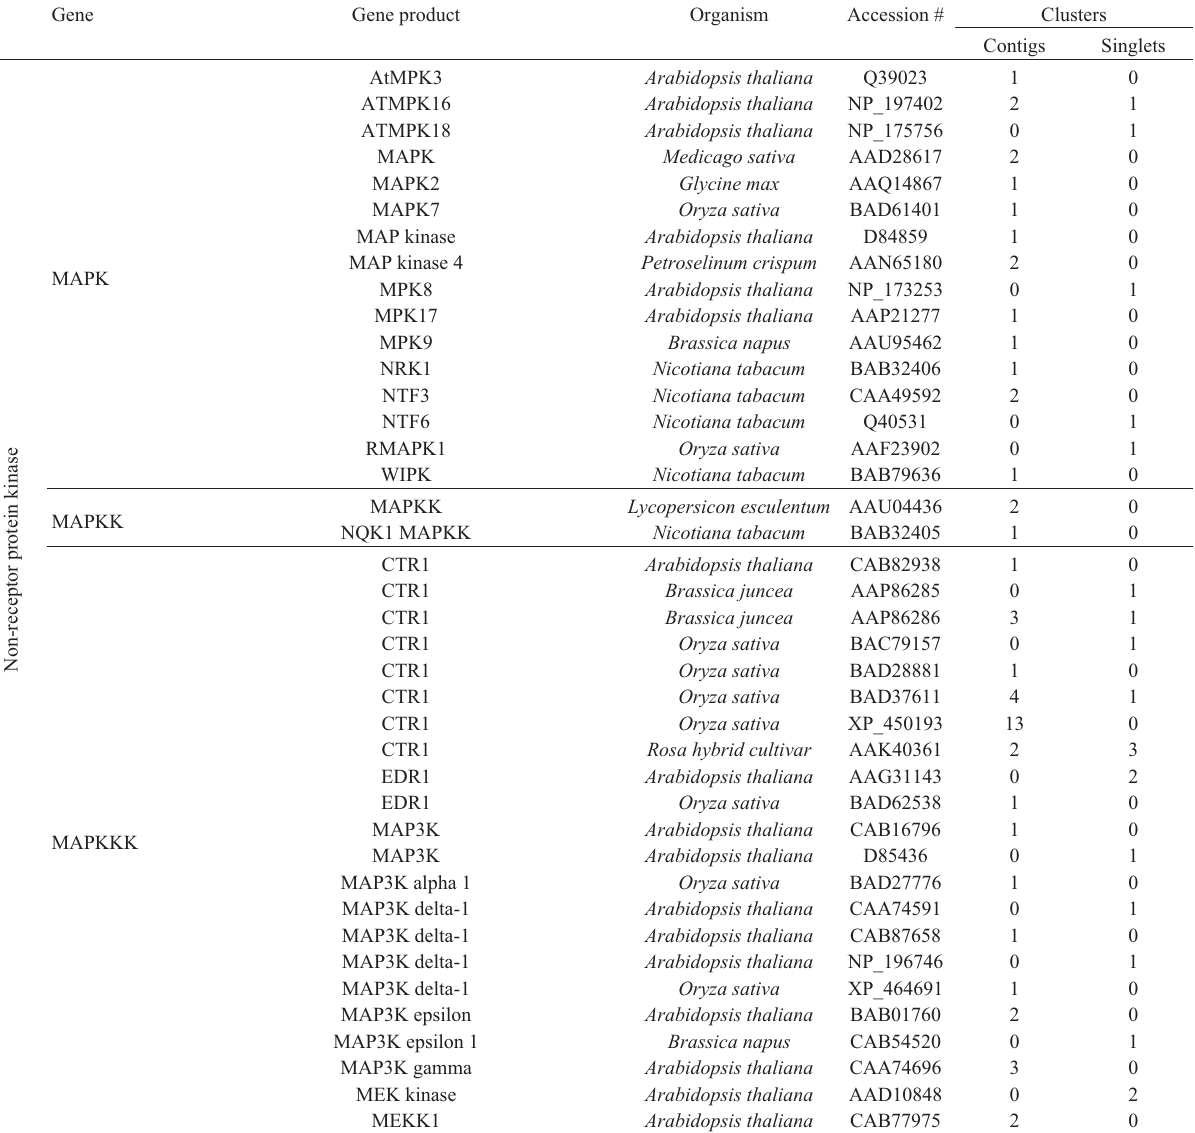
Table 8 - Ortholog genes of kinase and phosphatase signaling pathways found in the Citrus EST database.